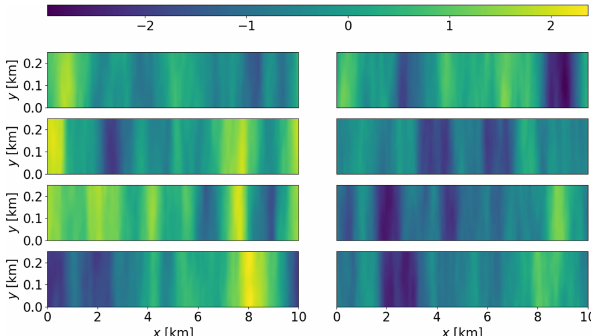
Figure 2. Samples of the flow rate pre-factor for Example 1. Left column: samples for Example 1a. Right column: samples for Ex- ample 1b. The samples in the top row are taken as the true flow rate pre-factors. Note that the axes have been stretched in the y direction for ease of